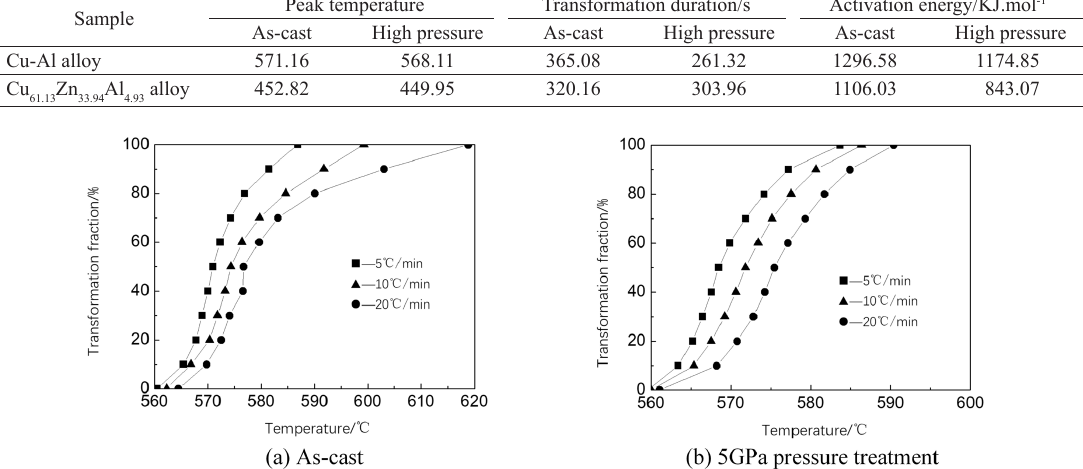
Fig.6 - Relationship between the transformation volume fraction and temperature before and after high pressure treatment at different heating rates